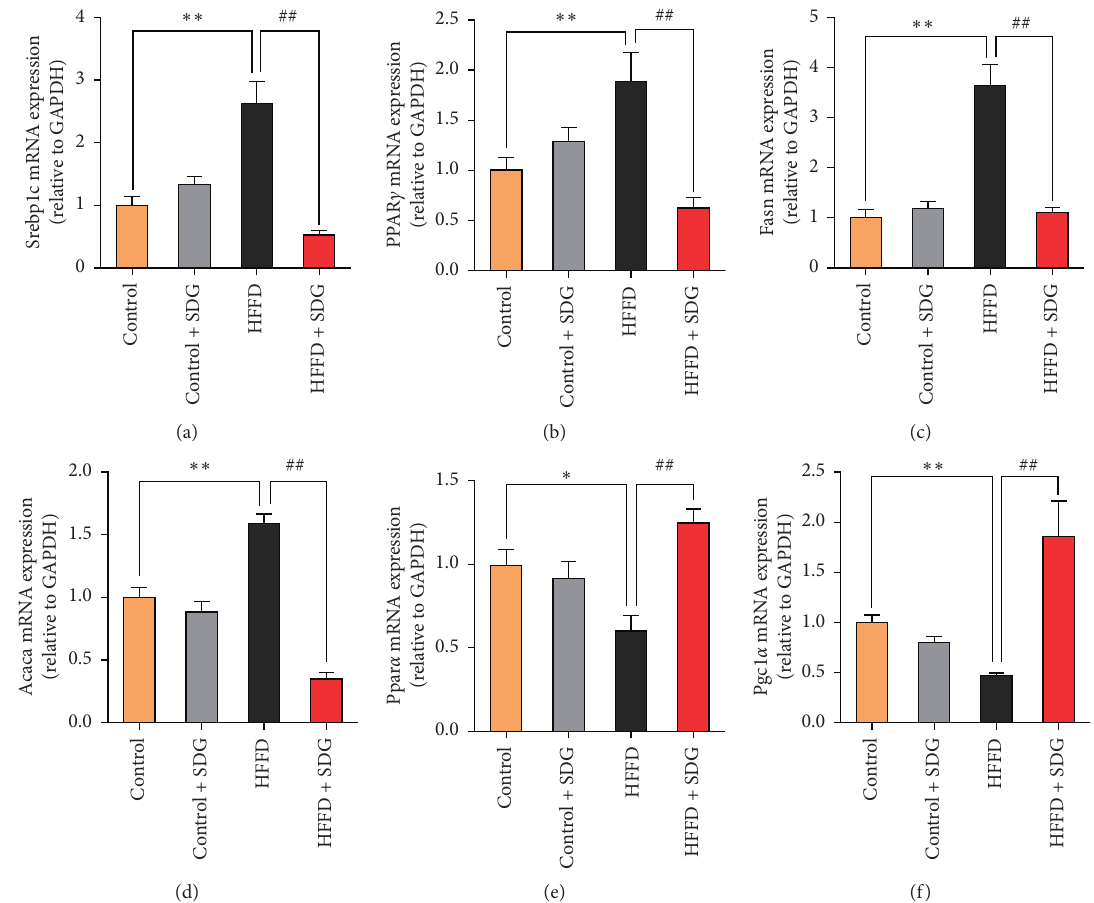
Figure 5: SDG regulates lipid metabolic genes in white adipose tissue of obese mice induced by a Western diet. (a) Srebp1c mRNA level; (b) PPAR c mRNA level; (c) Fasn mRNA level; (d) Acaca mRNA level; (e) Ppar α mRNA level; and (f) Pgc1 mRNA level. Data are represented as mean ± SEM, n � 10 biologically independent animals. ∗ p < 0 . 05, ∗∗ p < 0 . 01 versus the control group; # p < 0 . 05, ## p < 0 . 01 versus the HFFD group.